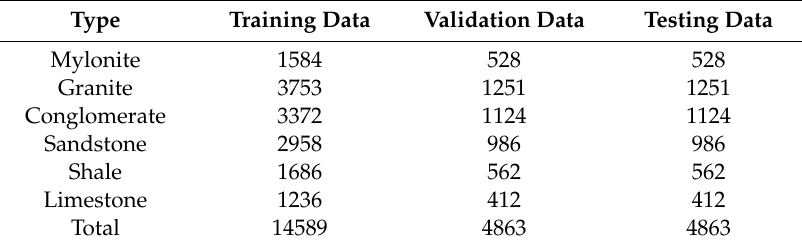
Table 3. Datasets for image classification of field rocks.